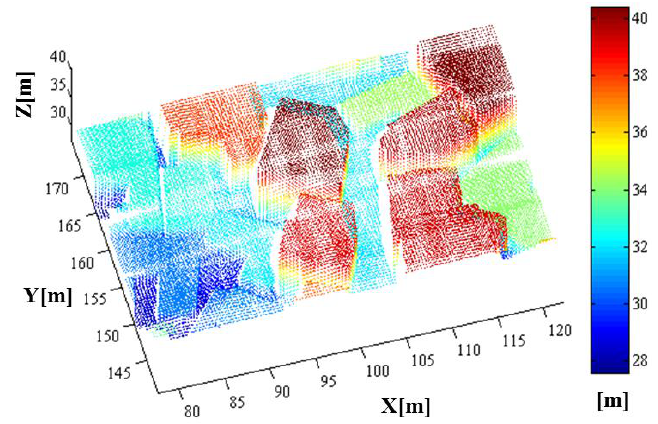
Figure 17. Reference point cloud generated by geometric simulation. They are not affected by the radiometric conditions or the nature of the detector. Therefore, it can be used as a reference for the simulation outputs of the radiometric and detector models.